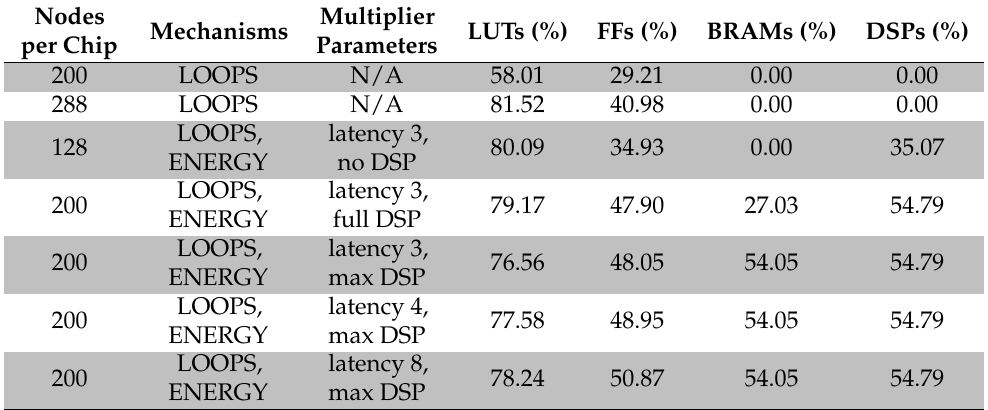
Table 2. Exploration of a design